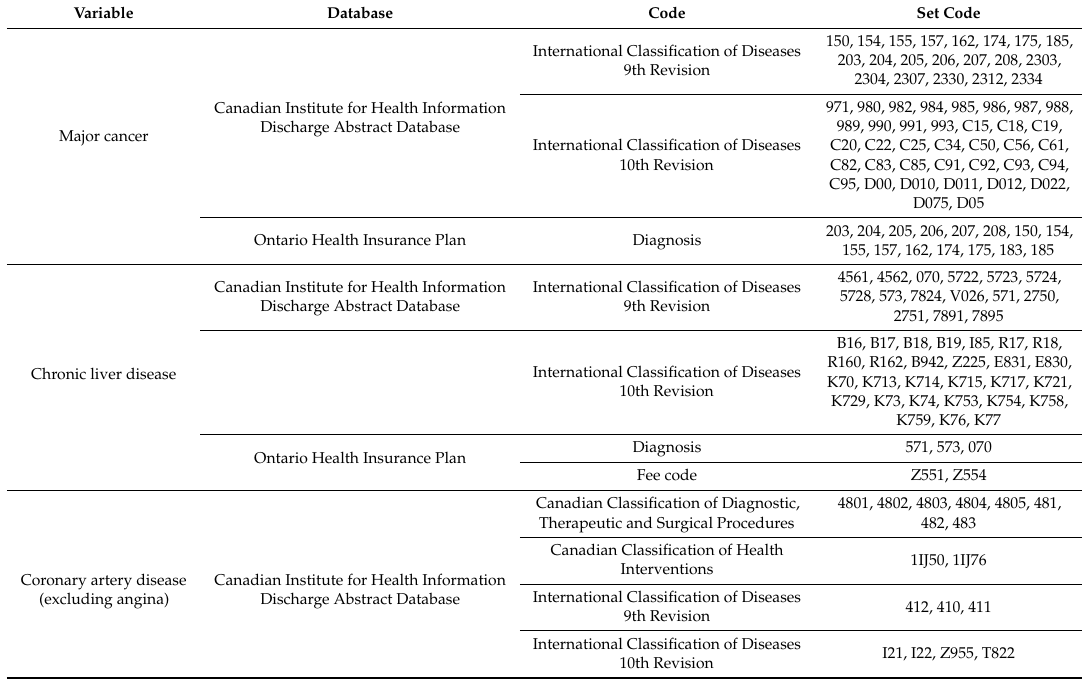
Table A2. Coding definitions for co-morbid